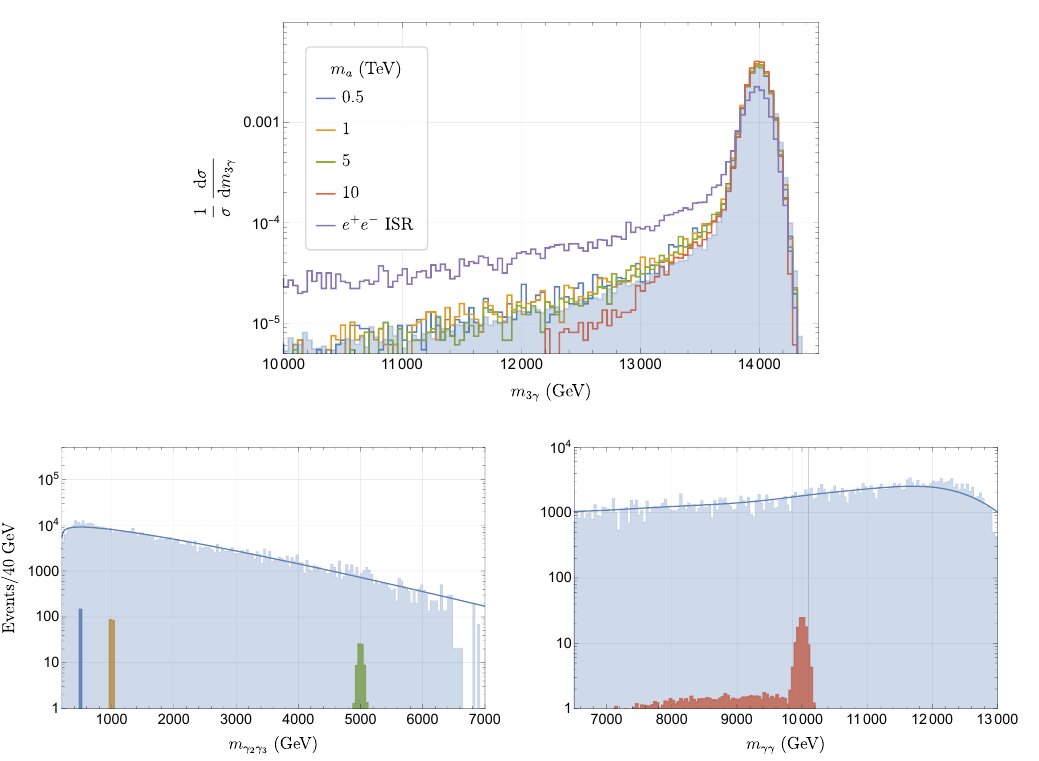
Figure 10 . Distributions for γa ( γγ ) associated production at a 14 -TeV muon collider with L = 10 ab − 1 data. In all panels, the light blue histograms represent the SM backgrounds. Top : Normalized distributions of reconstructed m 3 γ . The smooth m 3 γ tail below quence of the undetected ISR photon. As a reference, e + e − → 3 γ in SM with ISR at is also plotted. Bottom left : Reconstructed ALP peaks (for m a = 0 . 5 , 1 , 5 TeV) and the SM back- ground. Signals are scaled to the expected event counts when the production cross sections saturate the 2 σ exclusion limits. Bottom right : reconstructed ALP peaks (for m a = 10 TeV) over the SM background. The two vertical lines stand for the ad hoc m γγ ∈ [9 . 86 , 10 . 1] TeV